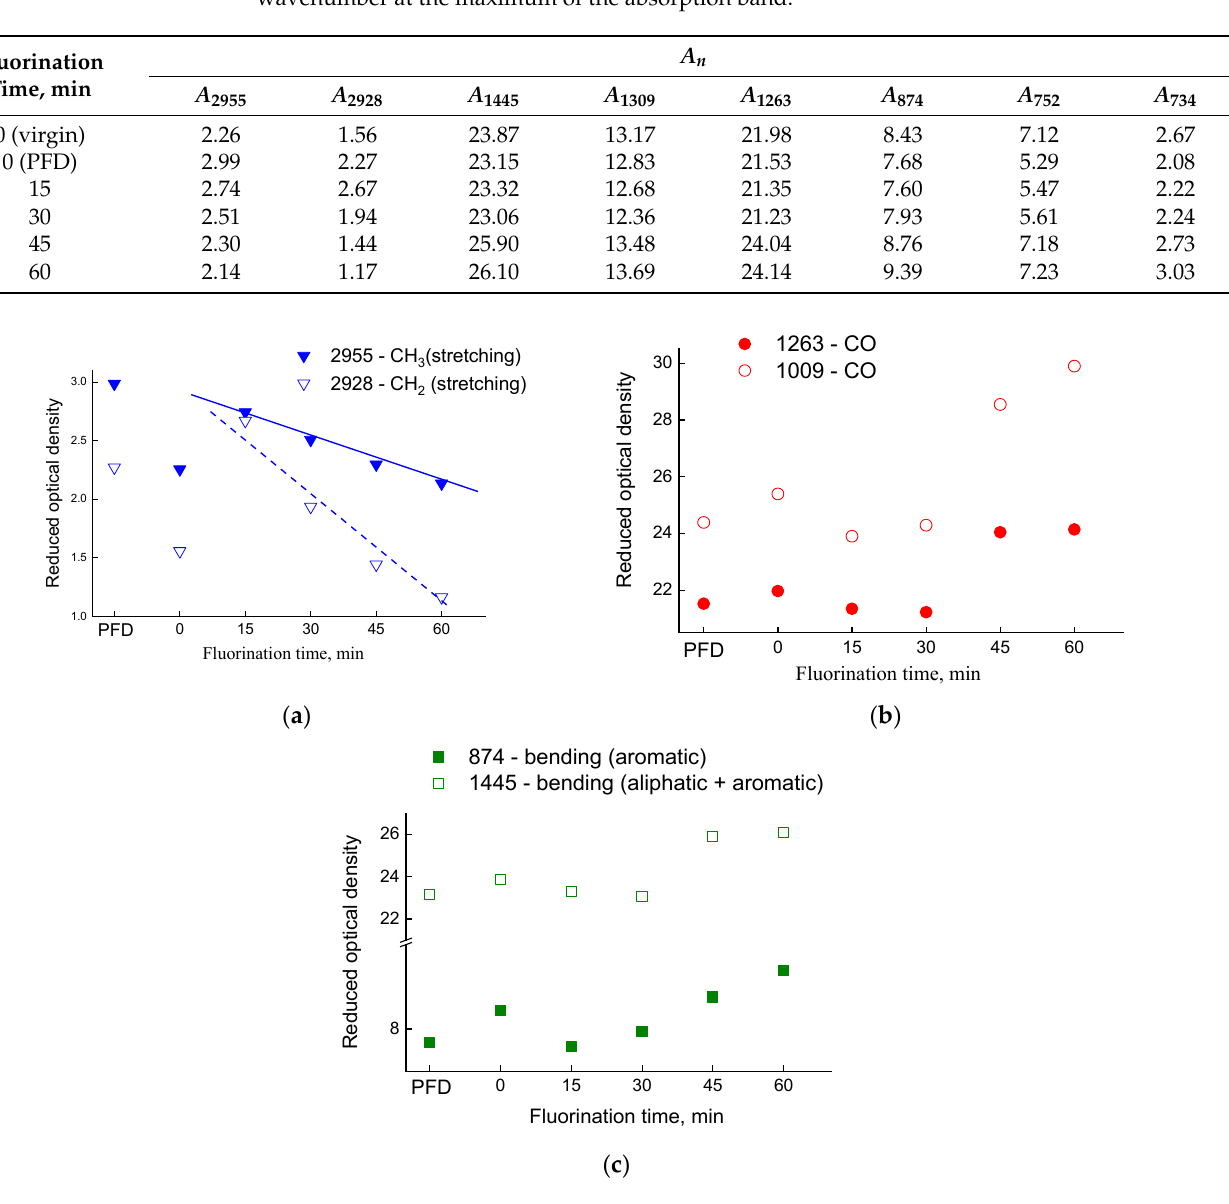
Figure 5. Changes in the optical density of some PIM-1 absorption bands from fluorination time for ( a ) aliphatic stretching vibrations (CH 3 and CH 2 ), ( b ) carbon-oxygen bonds and ( c ) bending vibrations of aromatic (C=C) and aliphatic (CH) groups.